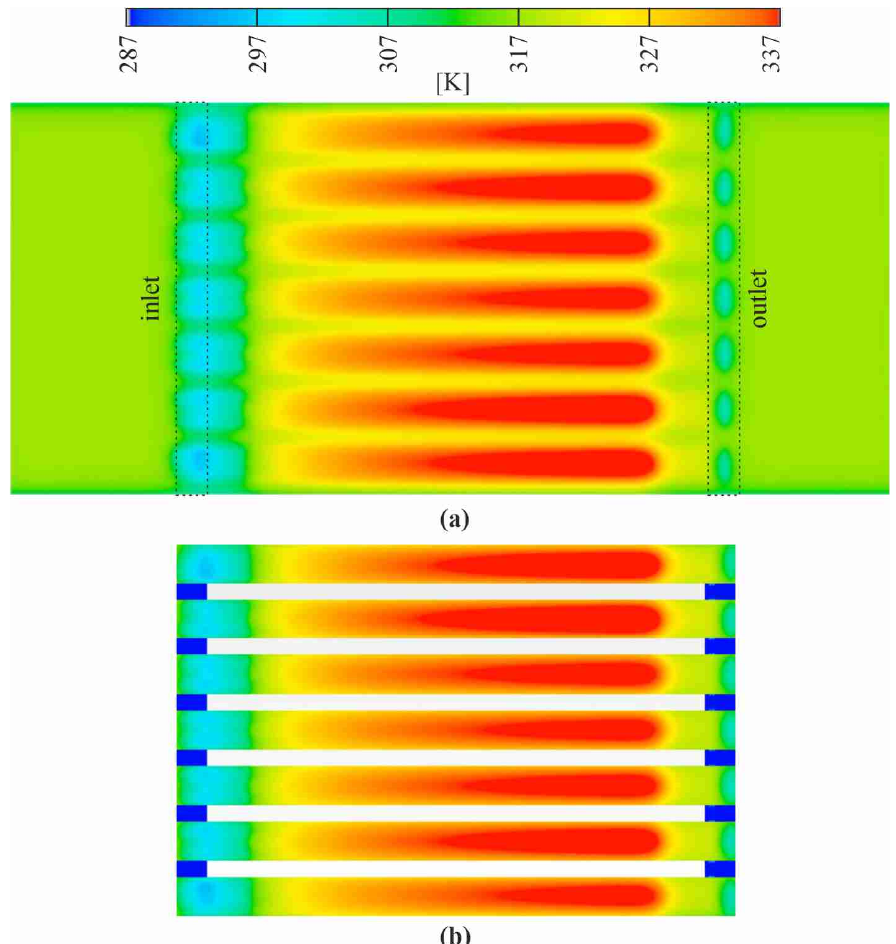
Figure 7. Two ‐ dimensional temperature distributions on: ( a ) the outer surface of the heated foil and ( b ) the fluid–heated foil contact surface; as the results from the numerical computations due to Simcenter STAR ‐ CCM+ software.